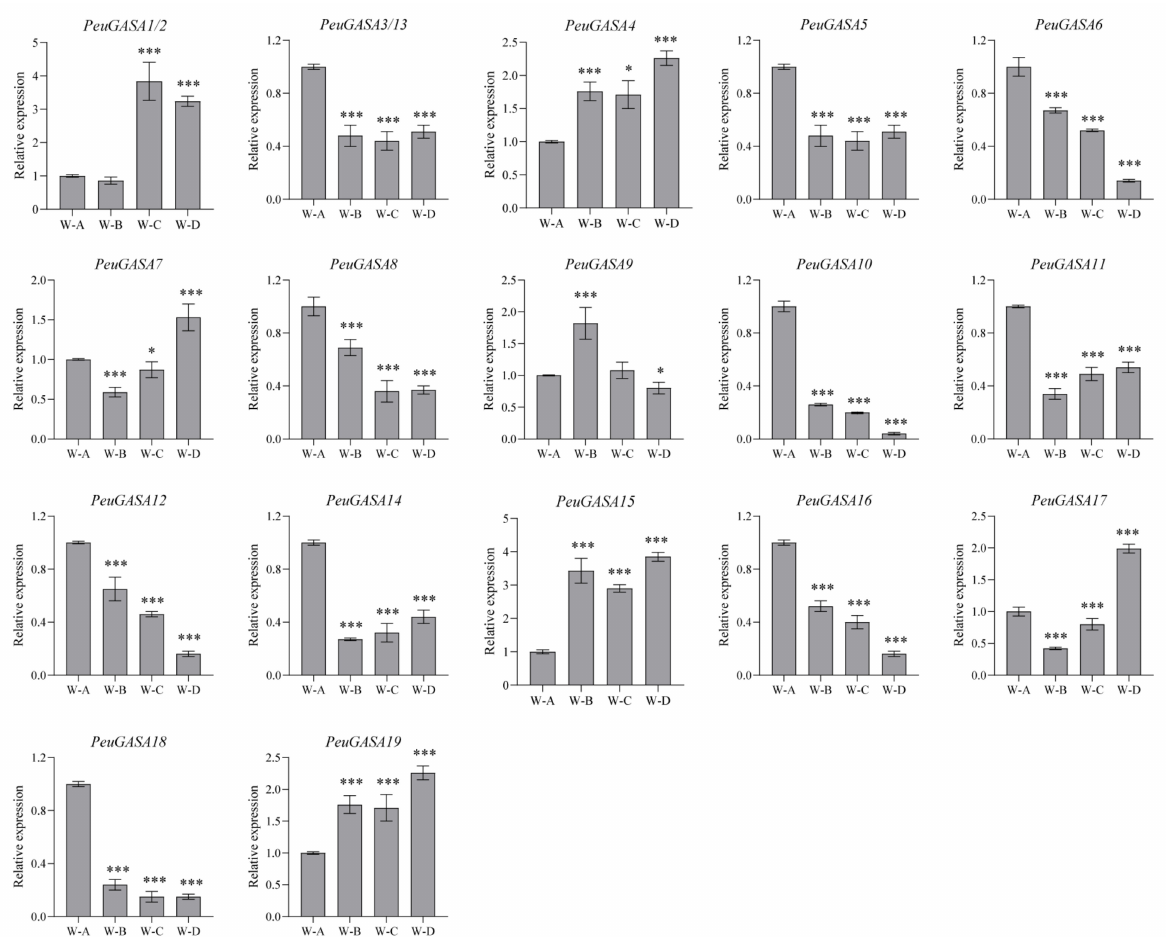
Figure 8. Expression analysis of PeuGASA genes in response to drought stress. W-A, W-B, W-C, and W-D respectively represented four drought treatments with different soil volumetric water content (soil-VWC): control (43 ± 1% soil-VWC), mild drought (33 ± 1% soil-VWC), moderate drought (23 ± 1% soil-VWC) and severe drought (13 ± 1% soil-VWC). Data were presented as mean ± standard error (SE). Subsequent multiple comparisons were evaluated based on the least significant difference (LSD) test to calculate p -values (Asterisks denoted significant differences: * p ≤ 0.05; *** p ≤